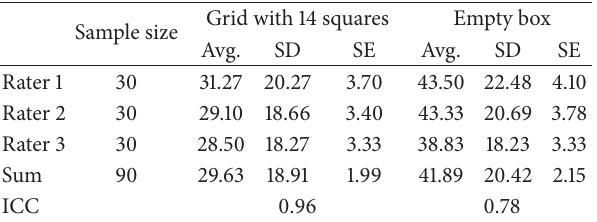
Table1:Fundamentalstatisticsandinterraterreliabilityfortheareas of retinal hemorrhage measured by using a grid with 14 squares and empty